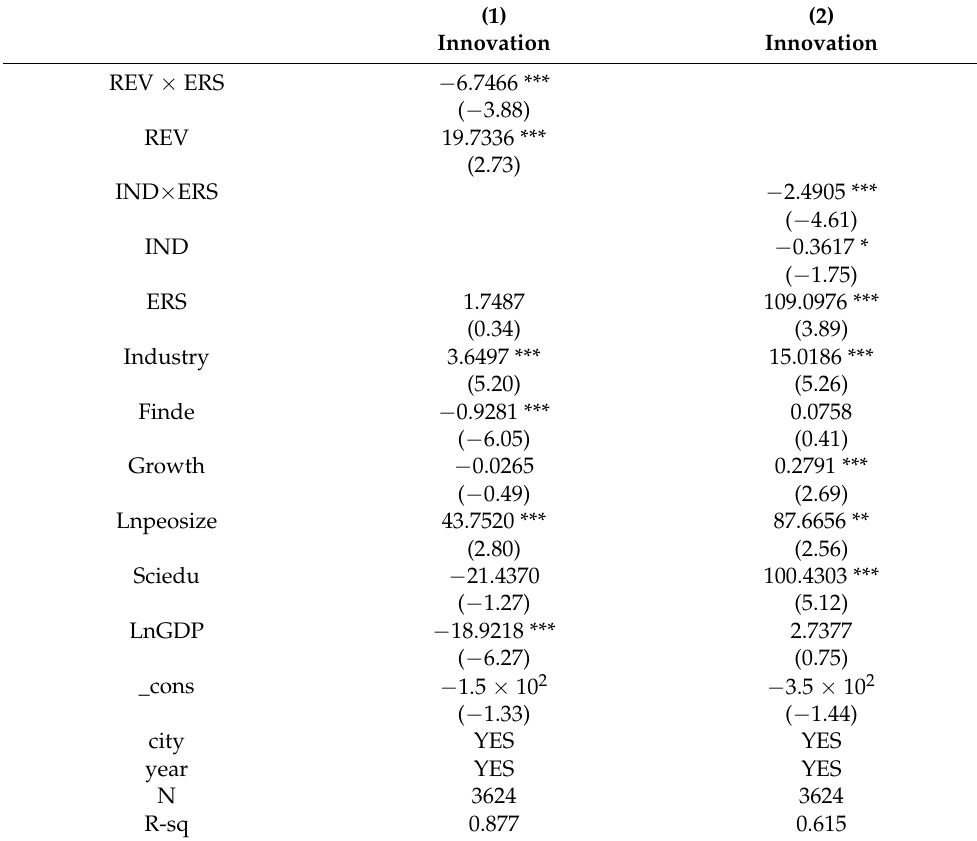
Table 13. Regression results of interaction terms between intermediate variable and environ- mental